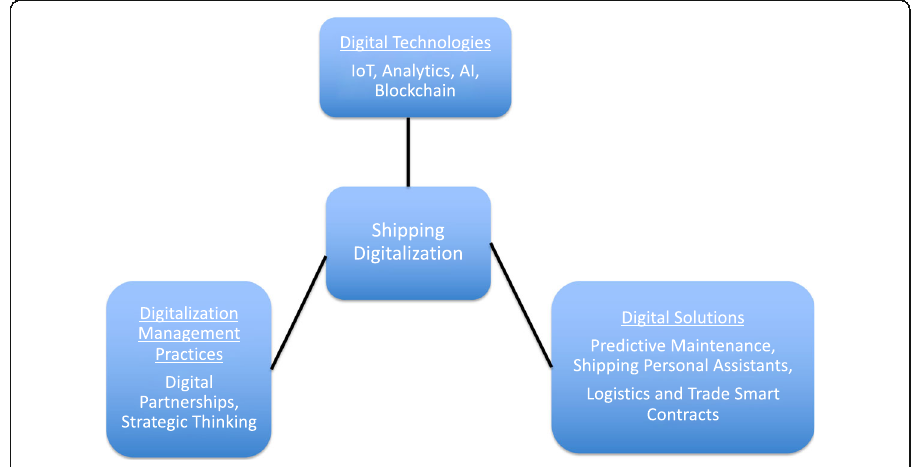
Fig. 2 A Baseline Model of Shipping